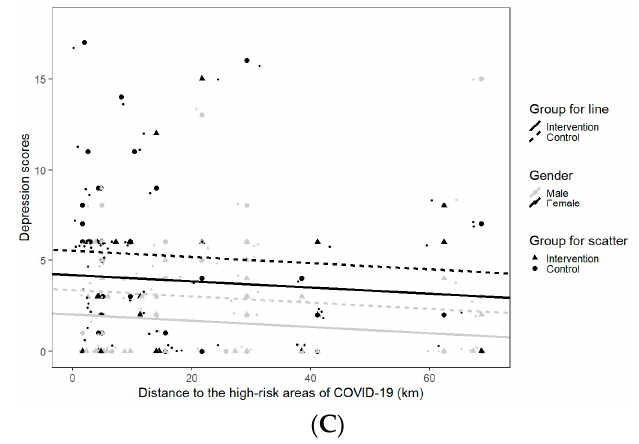
Figure 3. ( A ) Gender-specific differences in lifestyle-related behavior changes between intervention and control groups by distance to the high-risk areas of COVID-19 in Guangzhou. ( B ) Gender-specific differences in self-care activities between intervention and control groups by distance to the high-risk areas of COVID-19 in Guangzhou. ( C ) Gender-specific differences in depressive symptoms between intervention and control groups by distance to the high-risk areas of COVID-19 in Guangzhou.